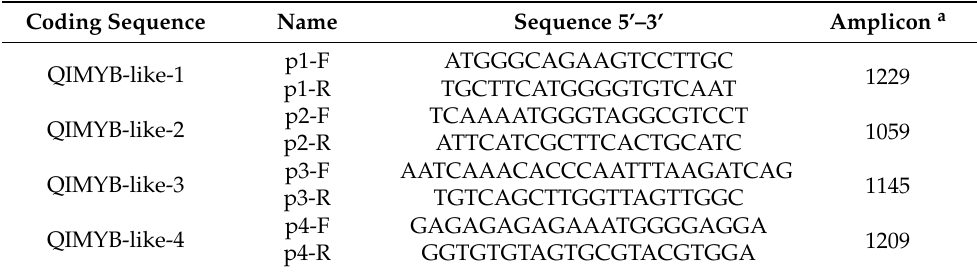
Figure 2. PCR-RFLP detection of QiMYB-like-1 genotypes. ( A ) QiMYB-like-1 D165H polymorphism, coding sequence encoded peptides. ( B ) MboI restriction map of PCR fragments amplified from Q. ilex by primers QIMYB-like-1 F and R, shown in Table 1. ( C ) Resolution in agarose gel (1.5%) electrophoresis (0.5 × TBE) of MboI fragments from QIMYB-like-1 specific PCR. Yellow, DNA polymorphisms; red/pink, protein polymorphisms; red, polymorphism detected by RFLP. Table 1. Primers used in this work.